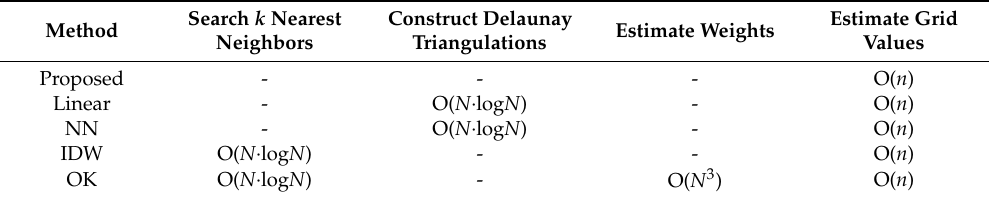
Time complexities of the proposed method and the classical interpolation methods for Dconstruction.